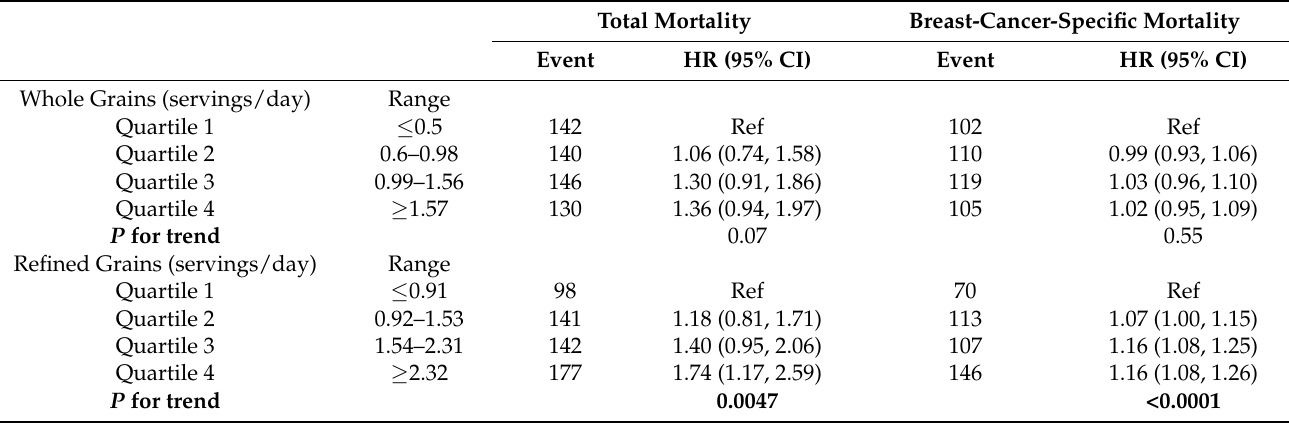
Table 3. Grain consumption in relation to total mortality and breast-cancer-specific